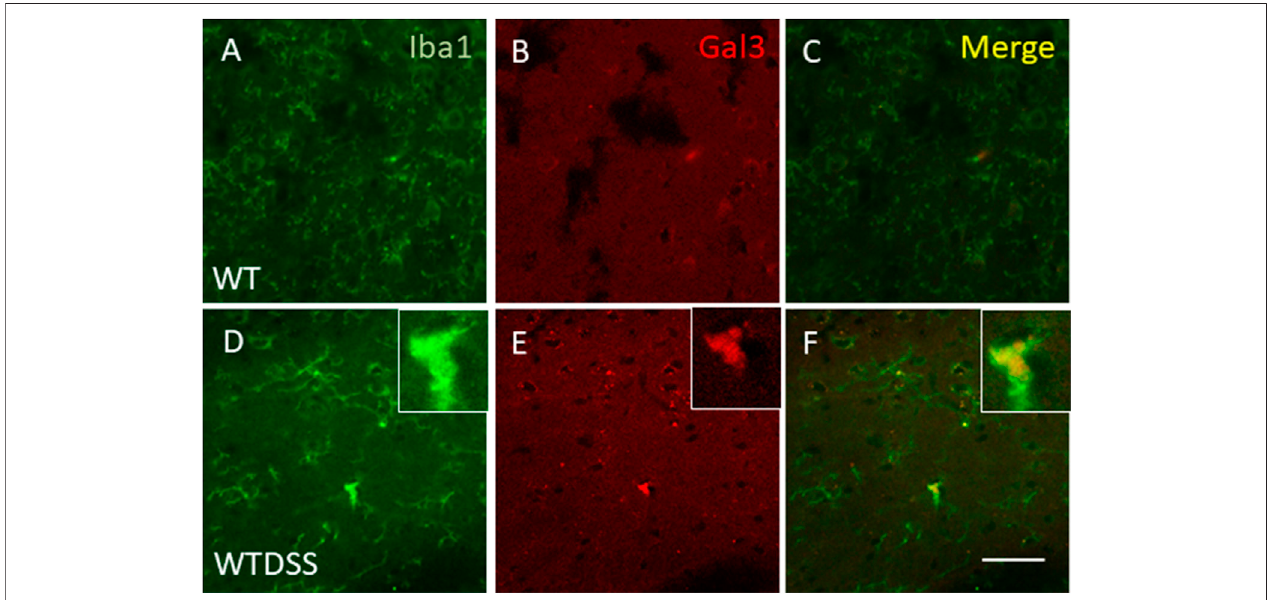
FIGURE9| ExpressionofGal3inDSS-activatedmicroglia.RepresentativeimagesfromsectionsofWT (A – C) andWTDSS (D – F) animalsshowingimmunostaining ofIba1(green) andGal3 (red). Asshown,onlyafewIba1 positivecellsco-localizedwithGal3(yellow) after thetreatment withDSS (F) .Scale bar:125 μ m. Abbreviations: WT, wild type mice; WTDSS, wild type mice treated with